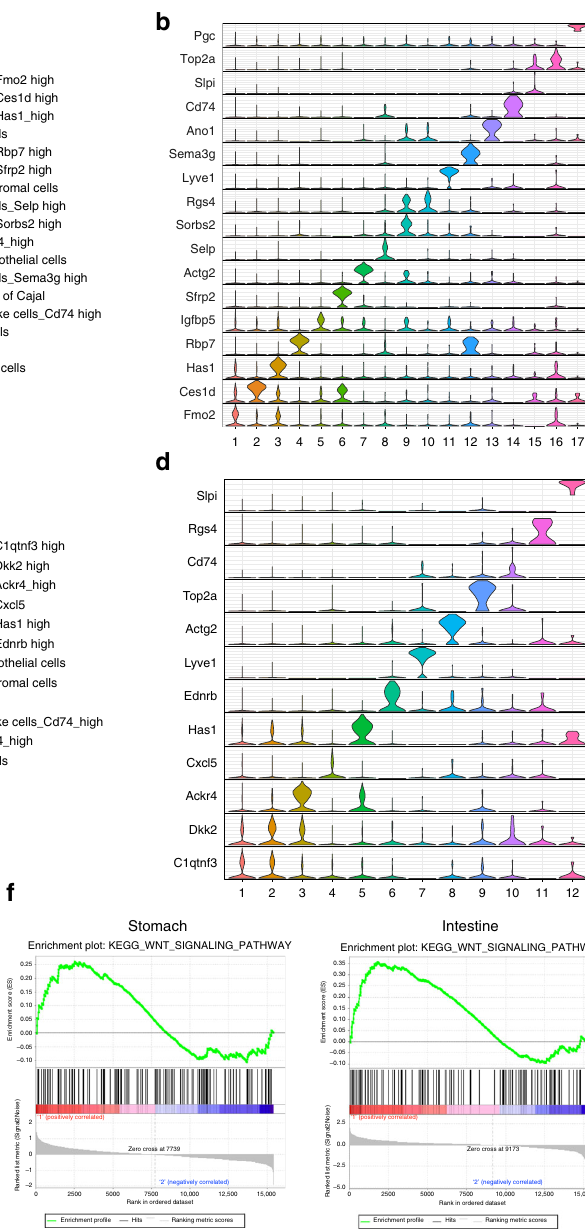
Stomach 0.8 0.7 Enrichment plot: KEGG_WNT_SIGNALING_PATHWAY Enrichment plot: KEGG_WNT_SIGNALING_PATHWAY